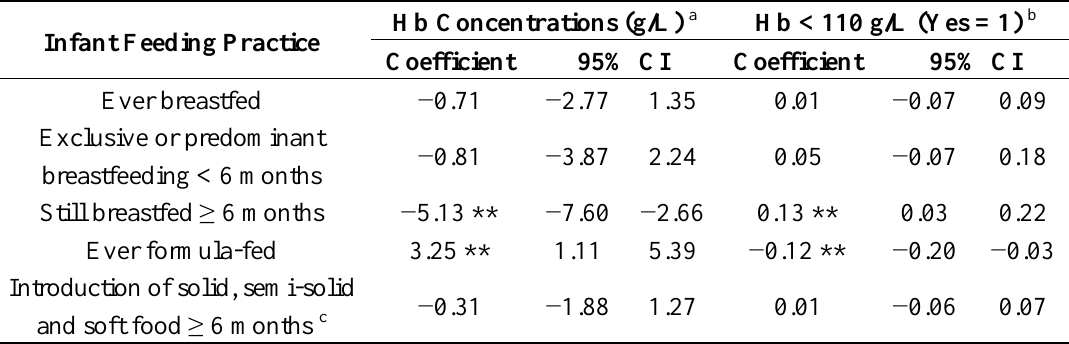
Table 8. Adjusted association of infant feeding practice, health and nutritional status in rural Shaanxi Province ( n =